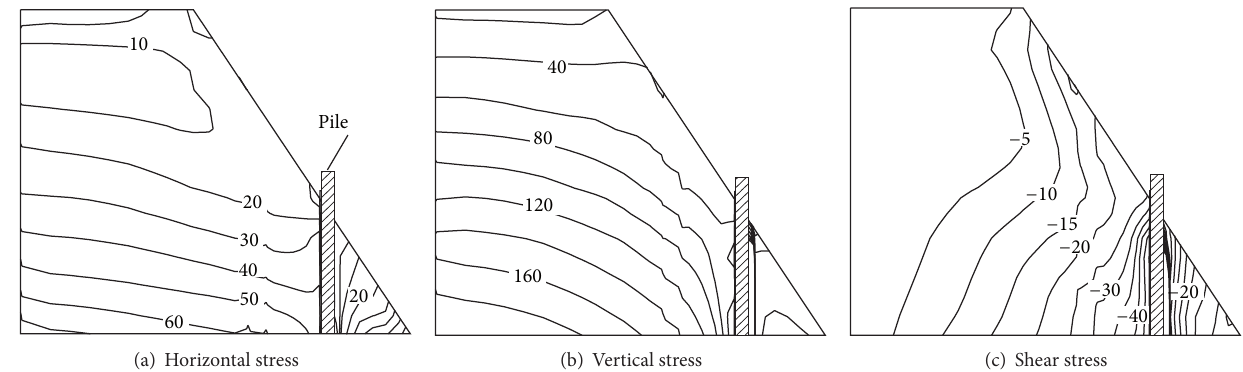
Figure 8: Stress distribution of the slope at 50 g-level by numerical analysis (unit: